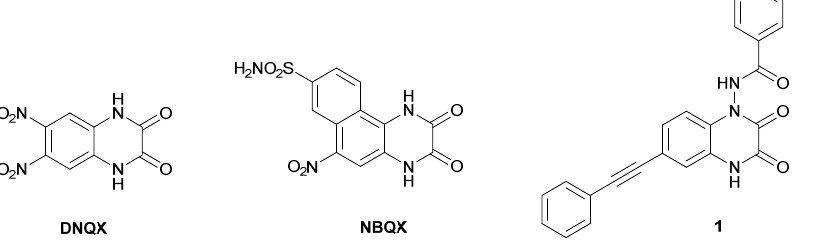
Figure 1. Structures of selected AMPA/kainate receptor antagonists based on the quinoxaline-2,3- dione core.